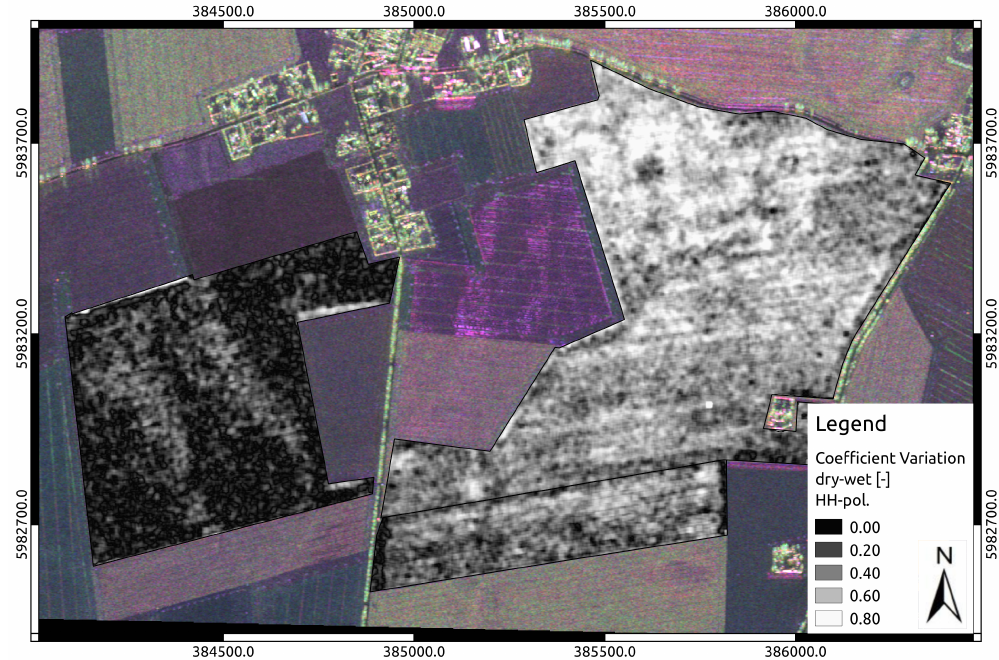
Figure 5. Co-variable based on the coefficient of variation of the backscatter values acquired from April to August at L-Band and HH polarization.